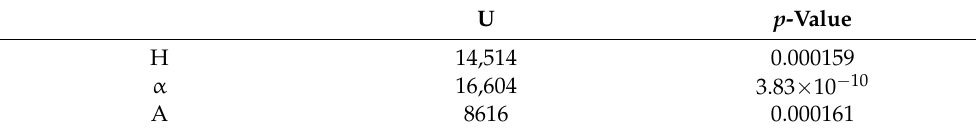
Table 1. MW test results obtained by comparing the H- α -A pixel distributions of DTFs and